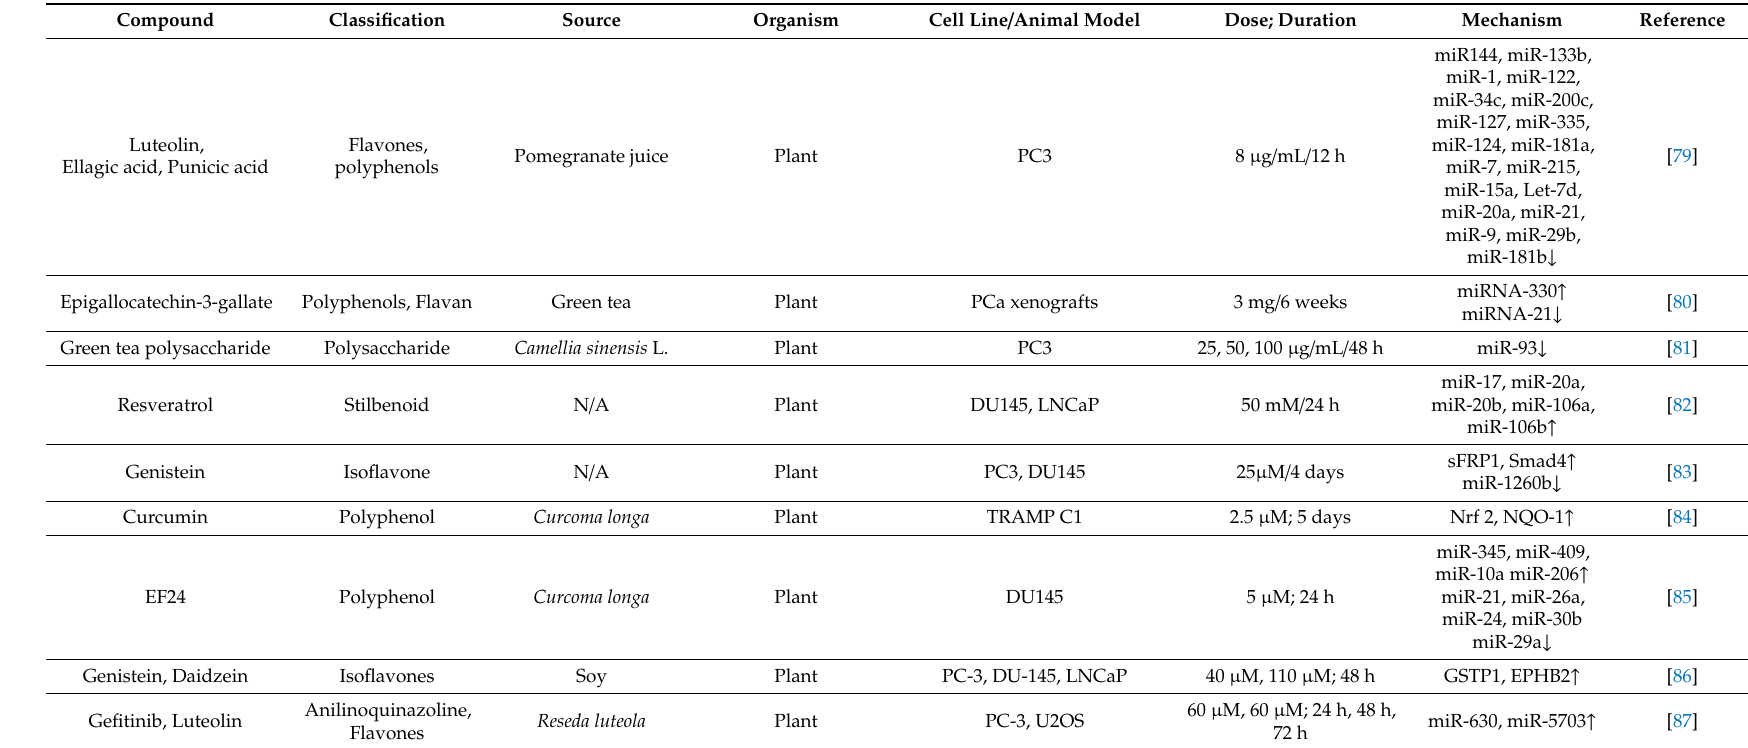
Table 7. MicroRNA (miRNA) regulating natural